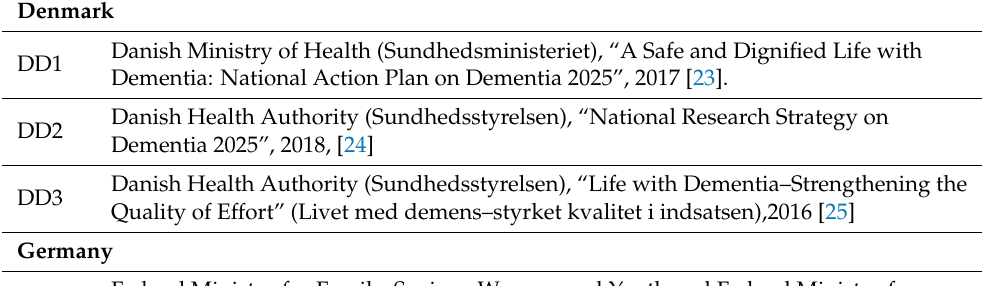
Table 1. Coded documents concerning the NDPs from the three countries. Denmark DD1